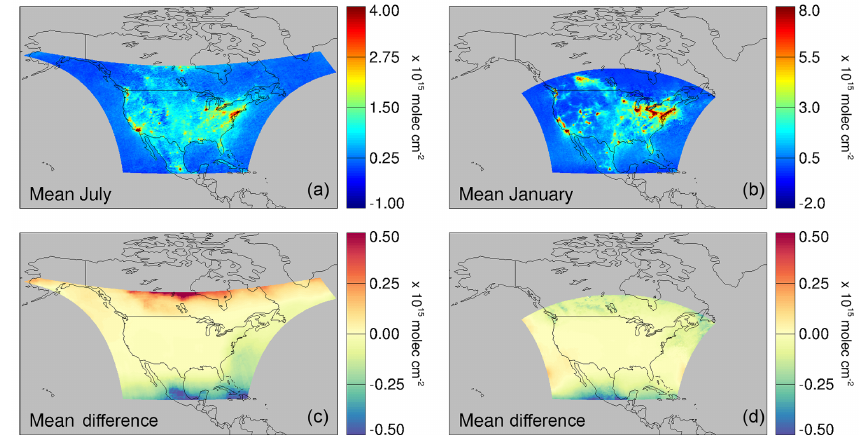
Figure 11. Panels (a, b) show mean July and January tropospheric NO 2 column densities resulting from our TEMPO STS algorithm without using independent low-Earth-orbit observations for context outside the TEMPO field of regard (as might be occasionally expected in near- real-time operations). Panels (c, d) show absolute difference in mean July and January tropospheric NO 2 between the TEMPO algorithm and the global STS